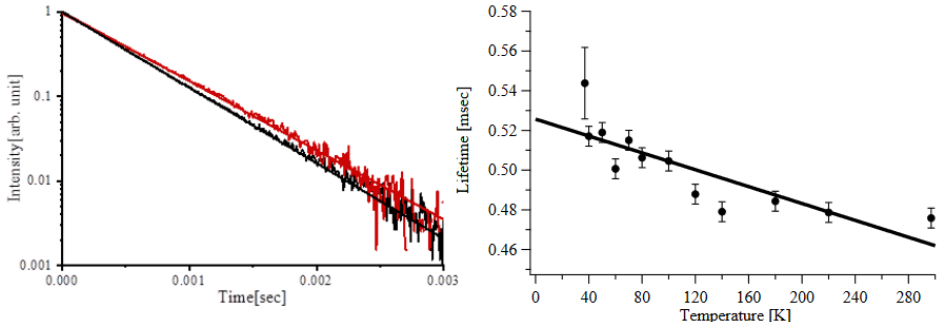
Figure 3. ( left ) Fluorescence decay of 1% Nd:YLF, 4 F 3/2 level at the temperature of 30 K (red and 300 K (black). ( right ) Measured lifetime vs. sample temperature, the continuous line is a linear best fit.